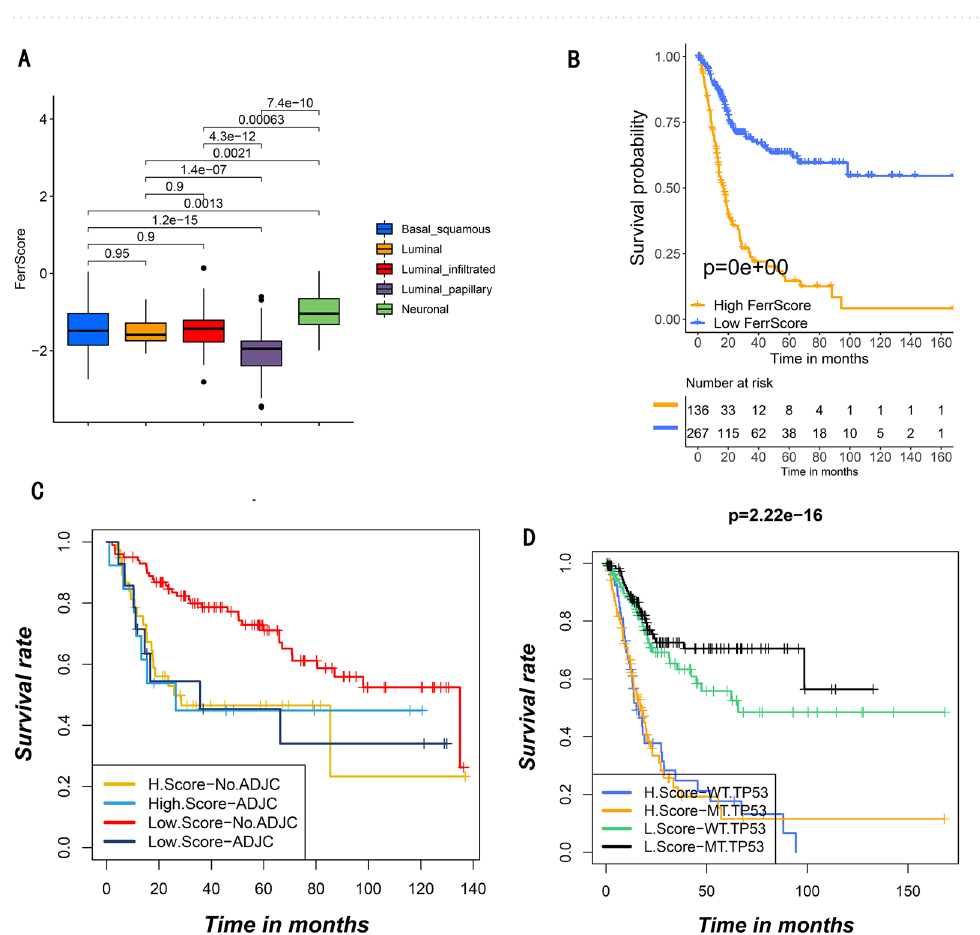
Figure 4. Signature construction of ferroptosis genes. ( A ) Unmonitored clustering of overlapping ferroptosis subtype-related genes in TCGA datasets to attribute patients to different genomic subtypes, named as ferroptosis gene cluster A, B and C. Patient annotations were utilized by the gene clusters, ferroptosis subtypes, TCGA molecular patterns, stage of tumor, grade, histology, status of survival, gender and age. ( B ) Kaplan–Meier curves suggested that ferroptosis genomic phenotypes were significantly relevant to the 406 patients’ survival in TCGA: BLCA dataset, among the cohort, 149 patients were classified to cluster A, 137 patients were classified to cluster B and 120 patients were classified to cluster C ( p = 0.055, Log-rank test). ( C ) The results of 38 ferroptosis-related genes in these gene clusters. The interquartile range of values was represented by the boxes’ upper and lower ends, the median value is represented by the lines in the boxes, and outliers were shown by dots in black. The value of p is graphically shown by asterisks, of which * means that p is less than 0.05, ** means less than 0.01 and *** means less than 0.001. The test called one-way ANOVA was applied to check group diversity among these ferroptosis forms statistically. ( D ) The changes of ferroptosis clusters, TCGA molecular patterns, ferroptosis gene cluster and FerrScore shown by alluvial diagram. ( E ) Spearman analysis showing the connection between FerrScore and the known gene features in TCGA: BLCA dataset. Blue color represented negative correlation and red color represented positive correlation. ( F ) Diversities of FerrScore in these gene clusters. The difference of the gene clusters was compared statistically with the Kruskal–Wallis test ( p less than 0.05). ( G ) Diversities of FerrScore in these ferroptosis subtypes in TCGA: BLCA dataset ( p less than 0.05, Kruskal–Wallis test). ( H ) Diversities of stroma-activated pathways in groups of high and low FerrScore. EMT, epithelial-mesenchymal transition; Pan-F-TBRS, pan-fibroblast transforming growth factor (TGF)-β response signature. The interquartile value ranges were indicated by boxes lower and upper ends. The median value was indicated by those lines in the boxes, and outliers were shown with dots of black color. The value of p was graphically shown by asterisks, (***: p less than 0.001).